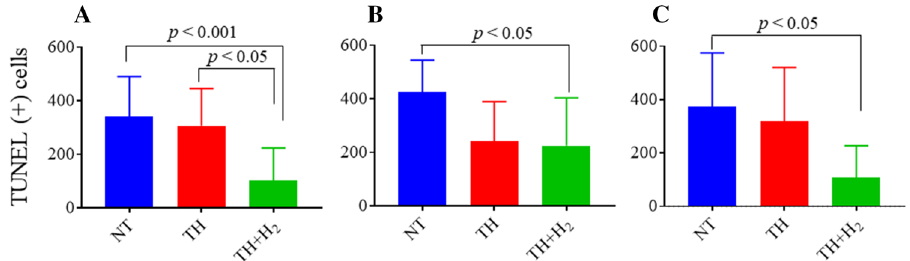
Figure 2. Number of TUNEL (+) cells in three regions of the cerebral cortex, namely, the dorsal cortex ( A , DCx), sensorimotor cortex ( B , SMCx), and mid-temporal cortex ( C , MTCx). In the DCx, significantly fewer TUNEL (+) cells were seen in the TH + H 2 group compared with the NT and TH groups (median with interquartile range). A p value < 0.05 was considered statistically significant. In the sensorimotor cortex (SMCx) and mid-temporal cortex (MTCx), the TH group showed significantly fewer cells compared with the NT